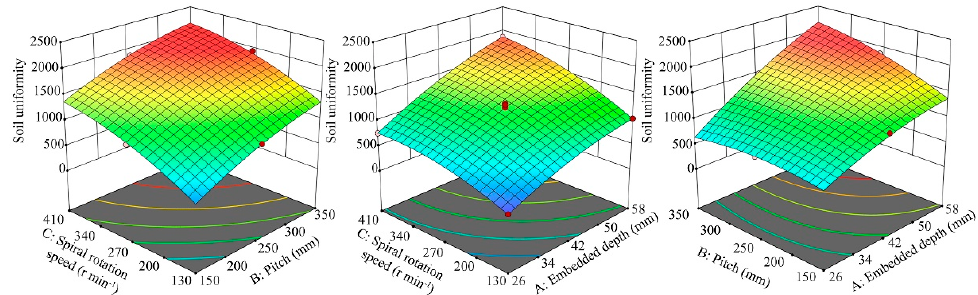
Figure 14. Response surface analysis of the relationship between test factors and soil uniformity.